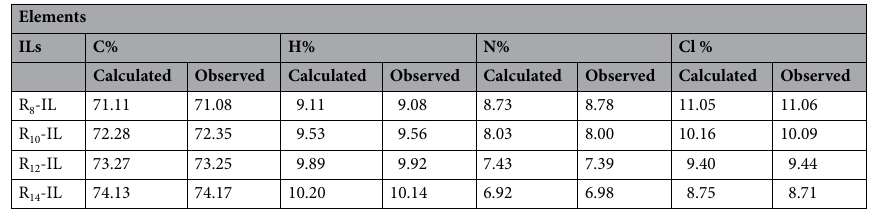
Table 3. Elemental analysis of R 8 -IL, R 10 -IL, R 12 -IL, and R 14 -IL.